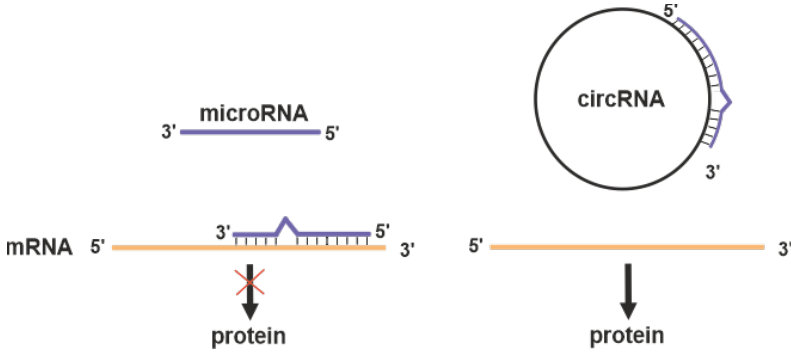
Figure 2. MicroRNA inhibits the translation of target mRNA (red cross on the black arrow). Circular RNAs (circRNA) may act as competitive inhibitor of microRNA preserving target protein expression.